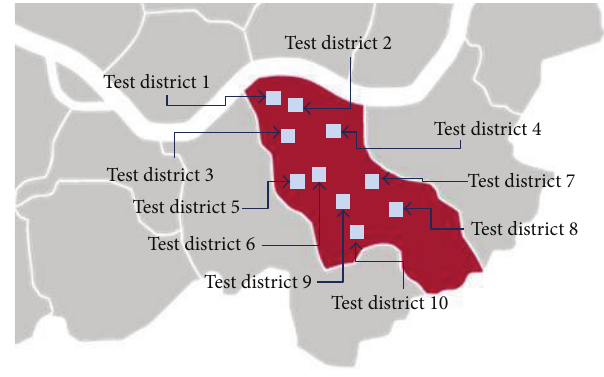
Figure 12: Test districts in Seoul Gangnam.